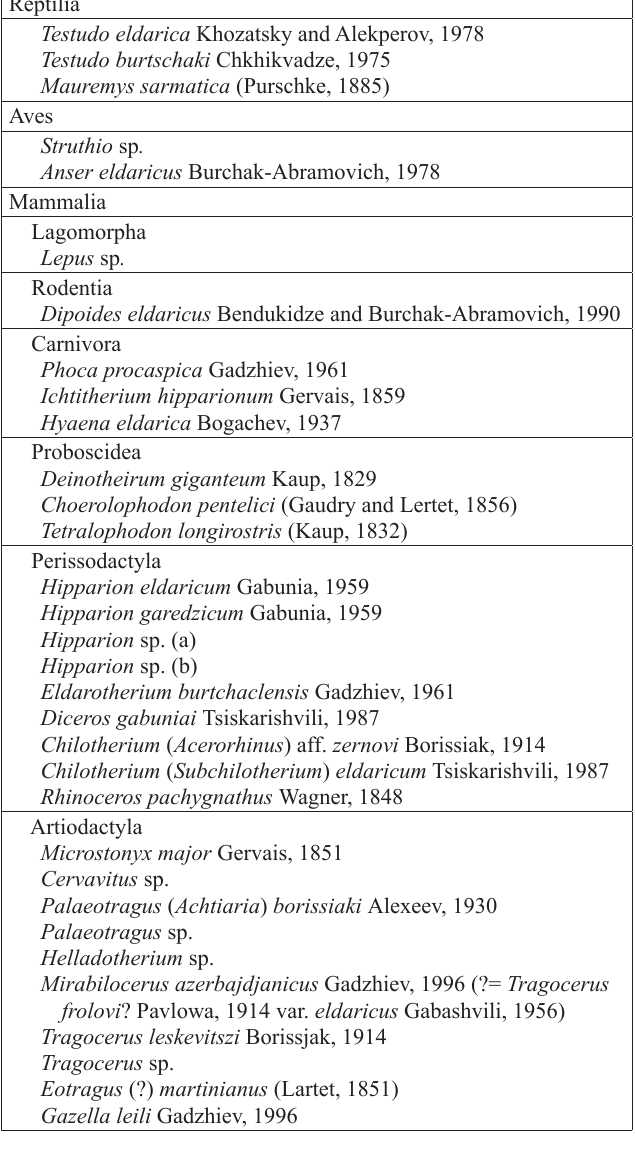
Table 1. Composite faunal list of Eldari. The list is mainly based on Gadzhiev 1996; reptiles are from Bakradze and Chkhikvadze 1984; Chkhikvadze and Amiranashvili 1996; birds from Burchak-Abramov- ich and Gadzhiev 1978; Hipparion garedzicum in the second fossil- bearing horizon from Vangengeim et al. 1989.